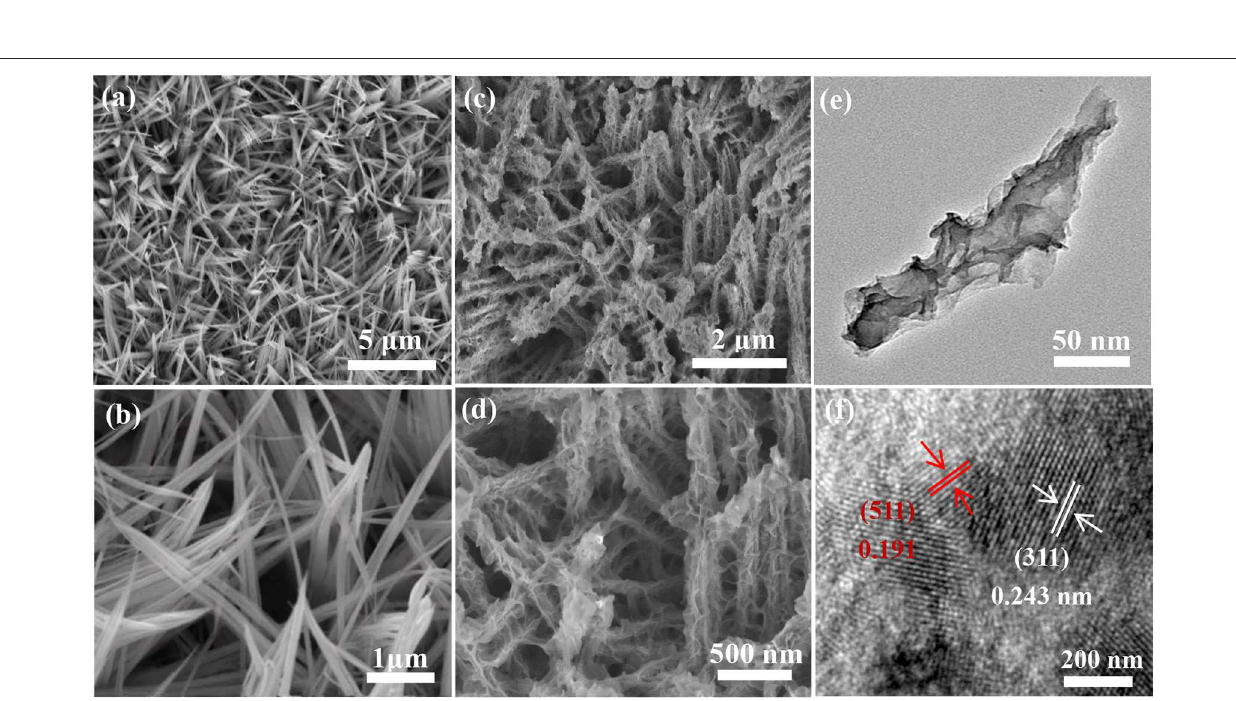
Frontiers in Materials |